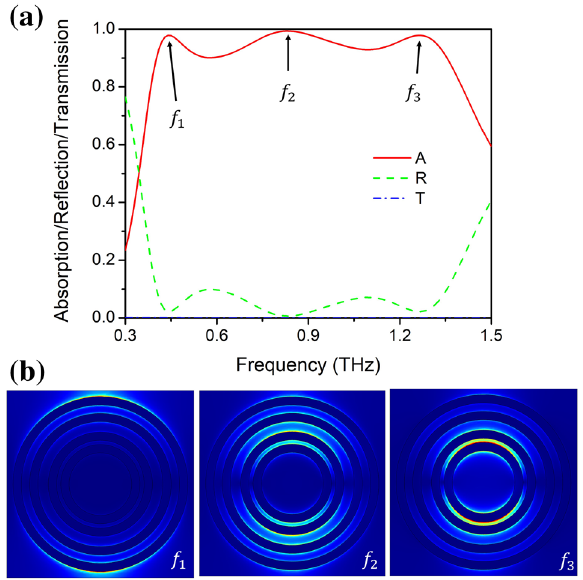
Figure 2. ( a ) Absorption spectra of ultra-broadband absorption structure at 358 K (VO 2 conductivity of 200,000 S/m). Red solid line (A) represents absorption rate, green dotted line (R) represents reflectivity, and blue dotted line (T) stands for transmittance. ( b ) Distribution of electric field at three peak locations of ultra- broadband absorption